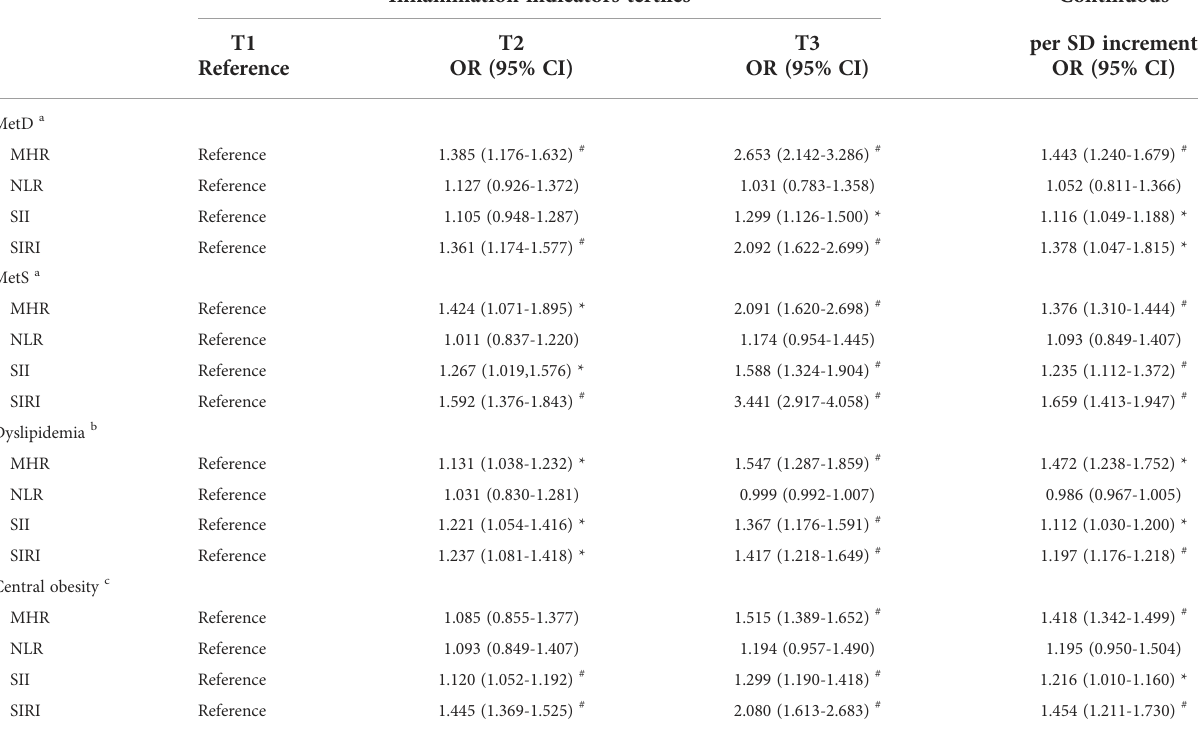
TABLE 4 In fl ammation states are associated with the risk of metabolic disorders and their